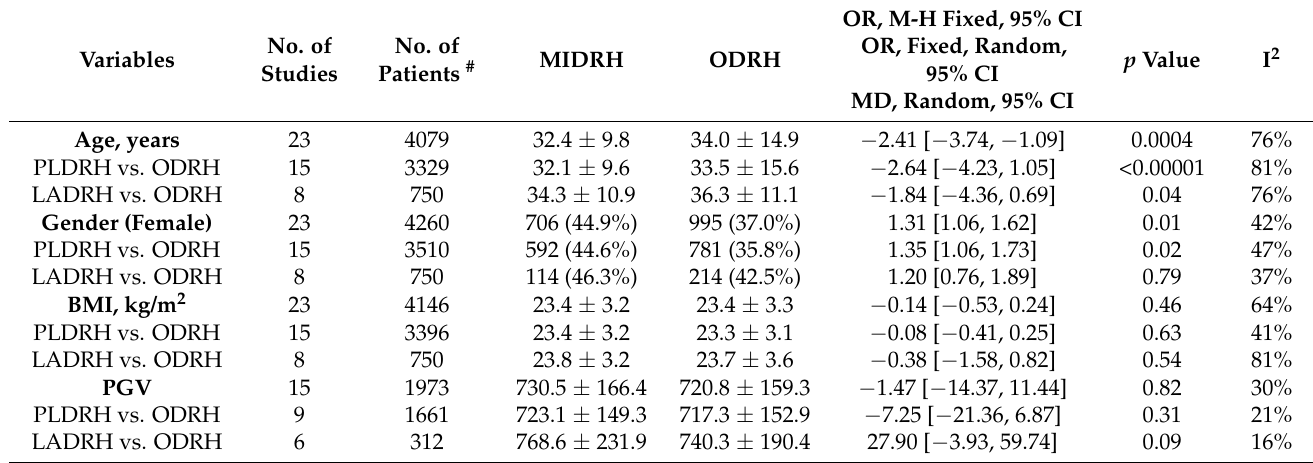
Table 2. Pooled donors’ preoperative characteristics.